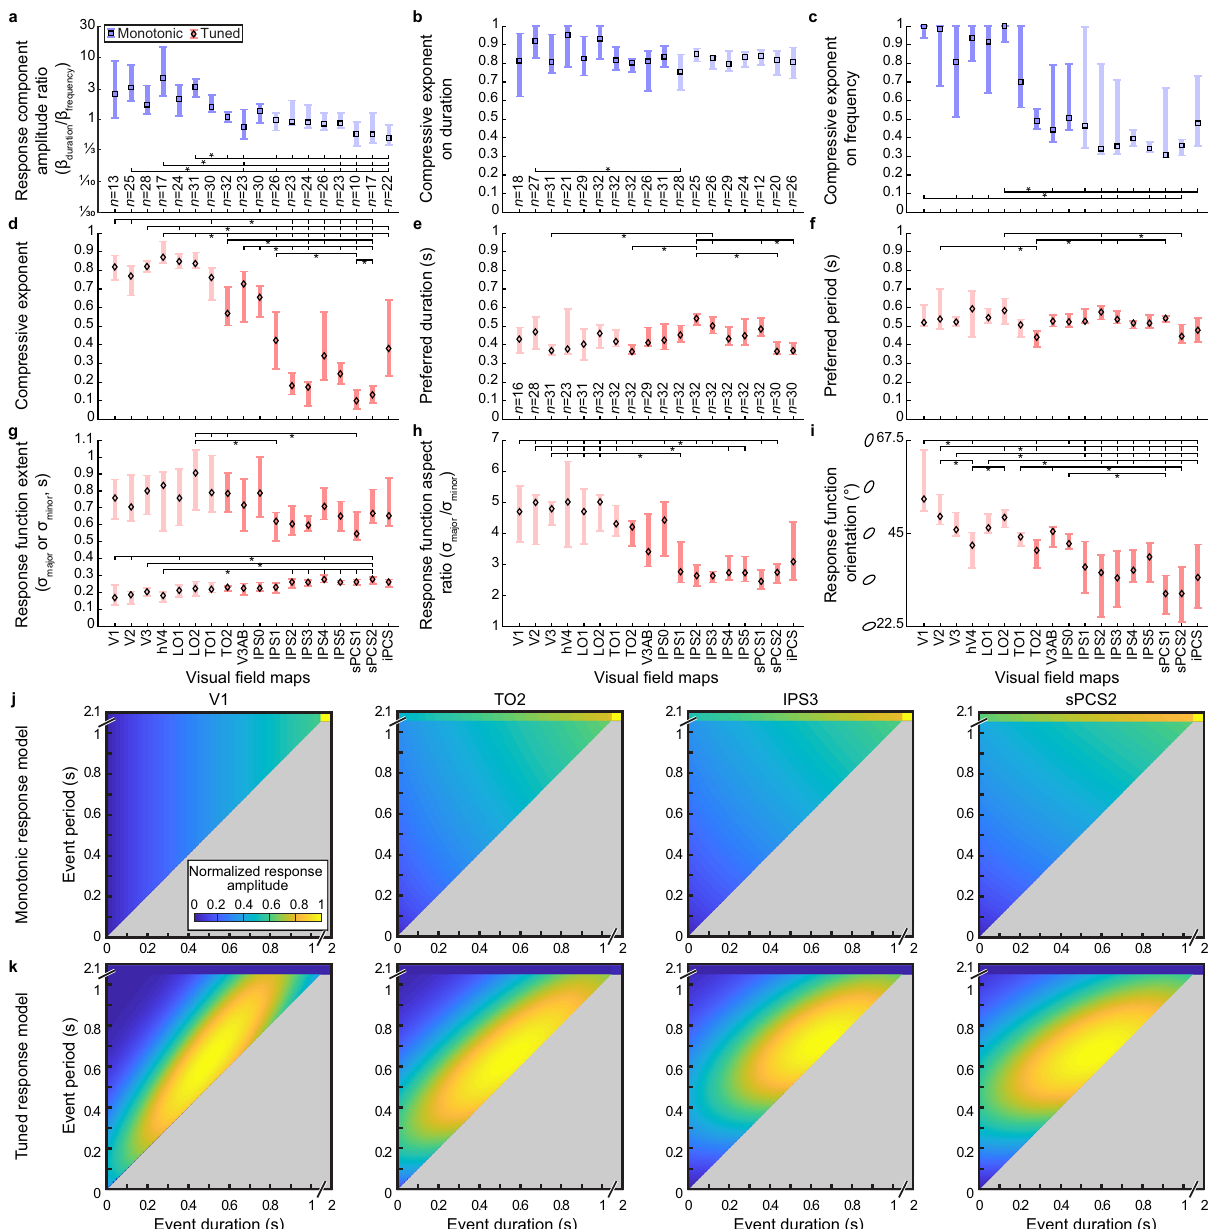
Fig. 4 Comparison of monotonic and tuned response model parameters between visual fi eld maps. a In the monotonic response model, the ratio of response amplitudes of the duration component divided by the frequency component decreased along the visual fi eld map hierarchy. b The duration component ’ s compressive exponent did not systematically change along the visual hierarchy. c The frequency component ’ s compressive exponent decreased along the visual hierarchy. d In the timing tuned response model, the compressive exponent on event frequency similarly decreased along the visual hierarchy. e , f The median preferred event duration and period did not systematically change along the visual hierarchy. g , h There was a decrease in the major extent and an increase in the minor extent of the response function (and consequently a decrease in their aspect ratio) along the visual hierarchy, particularly changing where tuned response models begin to dominate later visual fi eld maps ’ responses. i The response function ’ s orientation progressively rotated along the visual hierarchy, so the response function was narrower in the duration direction in the early visual fi eld maps (particularly where monotonic models fi t better than tuned models) and narrower in the period direction in the later visual fi eld maps. Points show the median parameter value across recordings from different hemispheres, error bars show 95% con fi dence intervals computed from 1000 bootstrap iterations. Brackets and stars show signi fi cant differences in multiple comparisons between all maps: all brackets to the left of the star are signi fi cantly different from all brackets to the right of the star (two-sided Dunn ’ s test, corrected for multiple comparisons, p < 0.05). n indicates the number of hemispheres included for the monotonic ( b , c ) or tuned response model ( d – i ) in each visual fi eld map. n deviates for the monotonic component ’ s ratio ( a ), as maps with all voxels ’ ratios of 0 or in fi nite were excluded. Light colors show visual fi eld maps where the shown response model captured responses signi fi cantly less well than the other response model. j , k Visualizations of response functions given by the median response model ’ s parameters in representative visual fi eld maps. Source data are provided as a Source Data fi